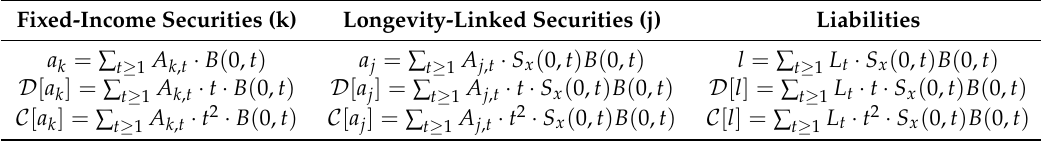
Table 4. Fisher-Weil Dollar Duration and Convexity for Asset and Liability Cash